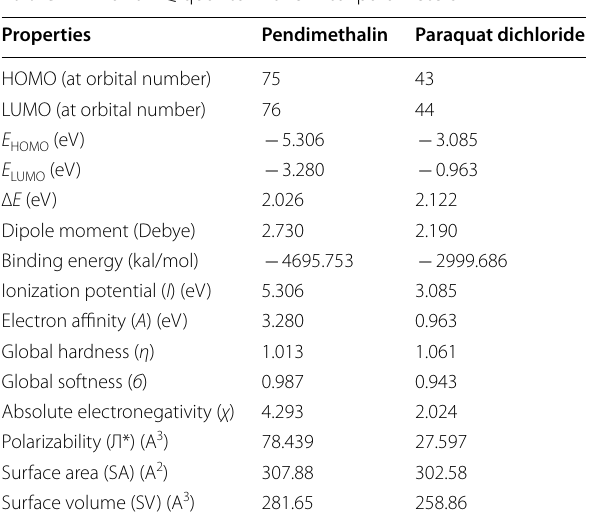
Table 4 PE and PQ quantum chemical parameters Properties Pendimethalin Paraquat dichloride HOMO (at orbital